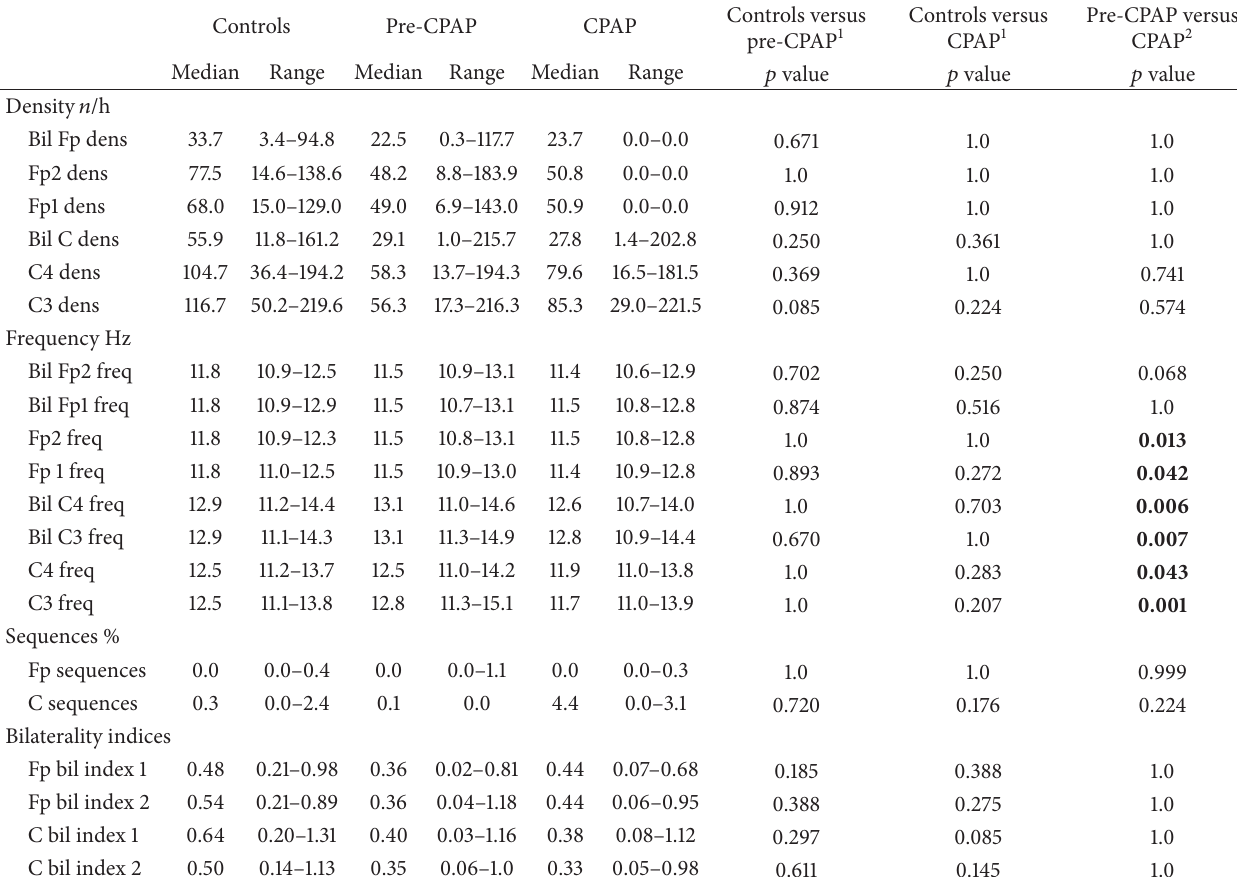
Table 2: Median and range of the spindle features in the study groups in the first part of the NREM time.